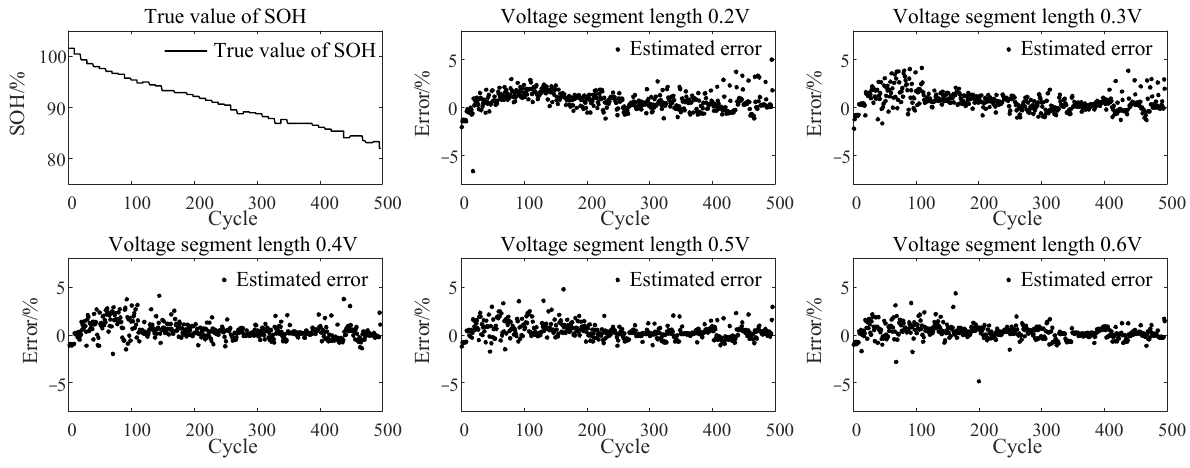
Figure 11. SOH estimation results under WLTC discharge.